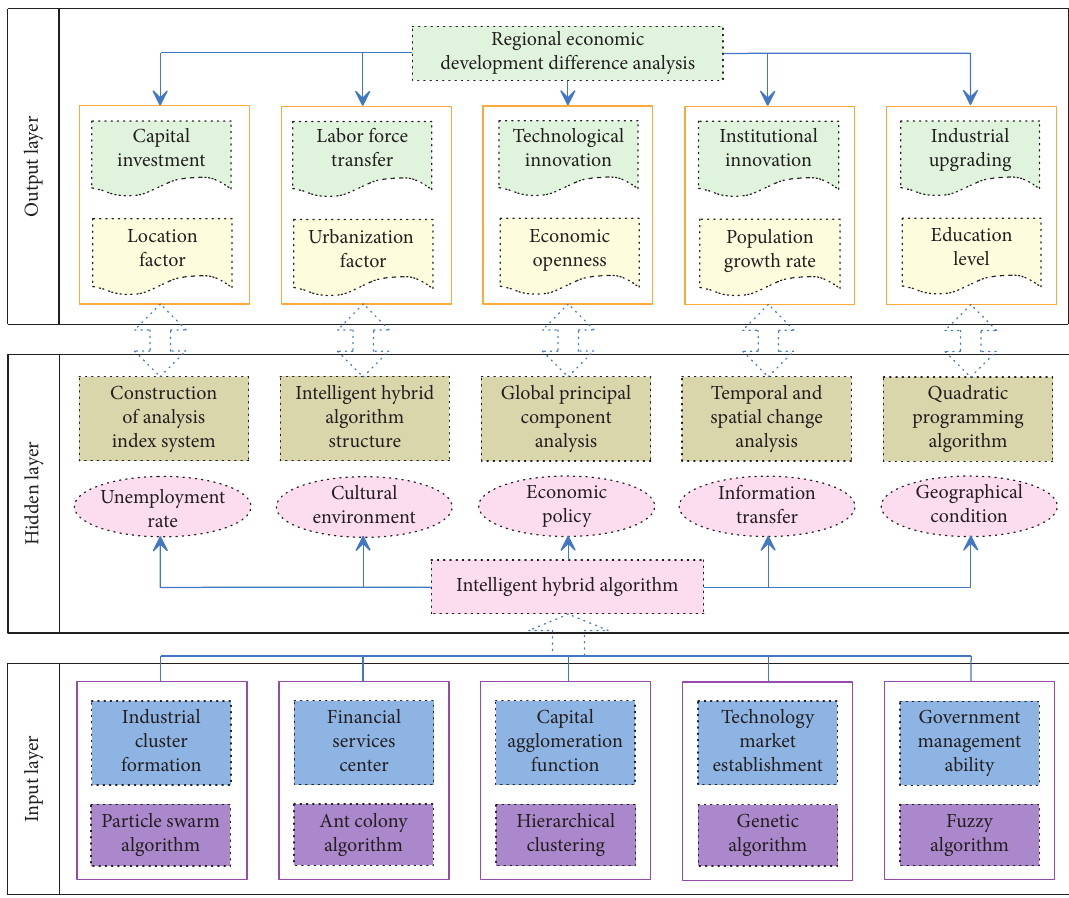
Figure 1: Framework of regional economic development difference analysis based on intelligent hybrid